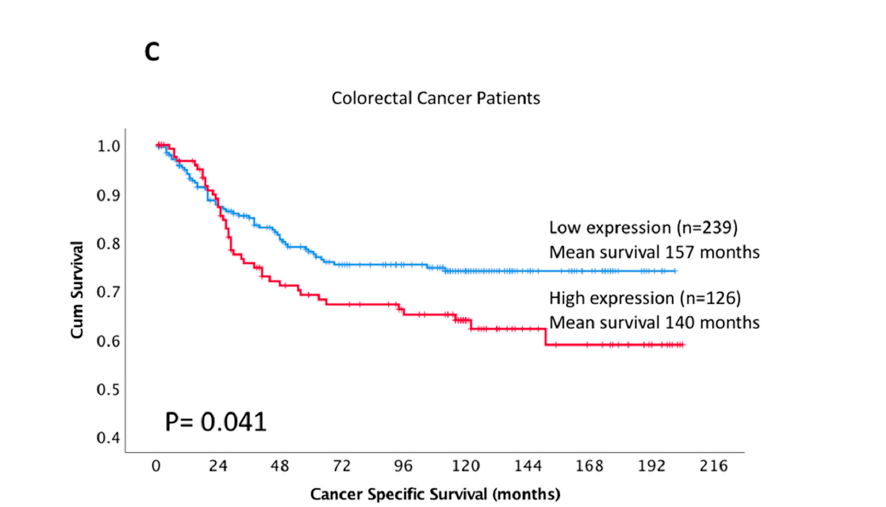
Figure 1. Relevance of the nuclear factor erythroid 2 (NF-E2) p45-related factor 2 (NRF2) pathway in colorectal tumours in vivo. ( A ) Bioinformatic analysis of the expression of various NRF2 target genes in normal and tumour tissues. The activity of NRF2 in colon (upper row) and rectal (lower row) cancers (T) and normal (N) tissues of the TCGA project was assessed through the expression of the NRF2 target genes NQO1 (left) and through the combined score from the expression of NQO1, GPX2, TXNRD1, GCLC and GCLM (right). p: p -value of the Welch’s t -test. ( B ) NQO1 expression in matched normal and tumour colorectal tissue quantified using real-time PCR. Figures show the combined data (upper panel) or individual patients (lower panel). The data were normalised using β -actin as an internal control. Data represent means ± SD ( n = 9). The di ff erences between the tumour and the normal tissue for NQO1 were statistically significant (paired t -test analysis) (* p = 0.0401). ( C ) Kaplan-Meier plots showing di ff erential cancer-specific survival for colorectal patients with high or low nuclear NRF2 levels ( p = 0.041).